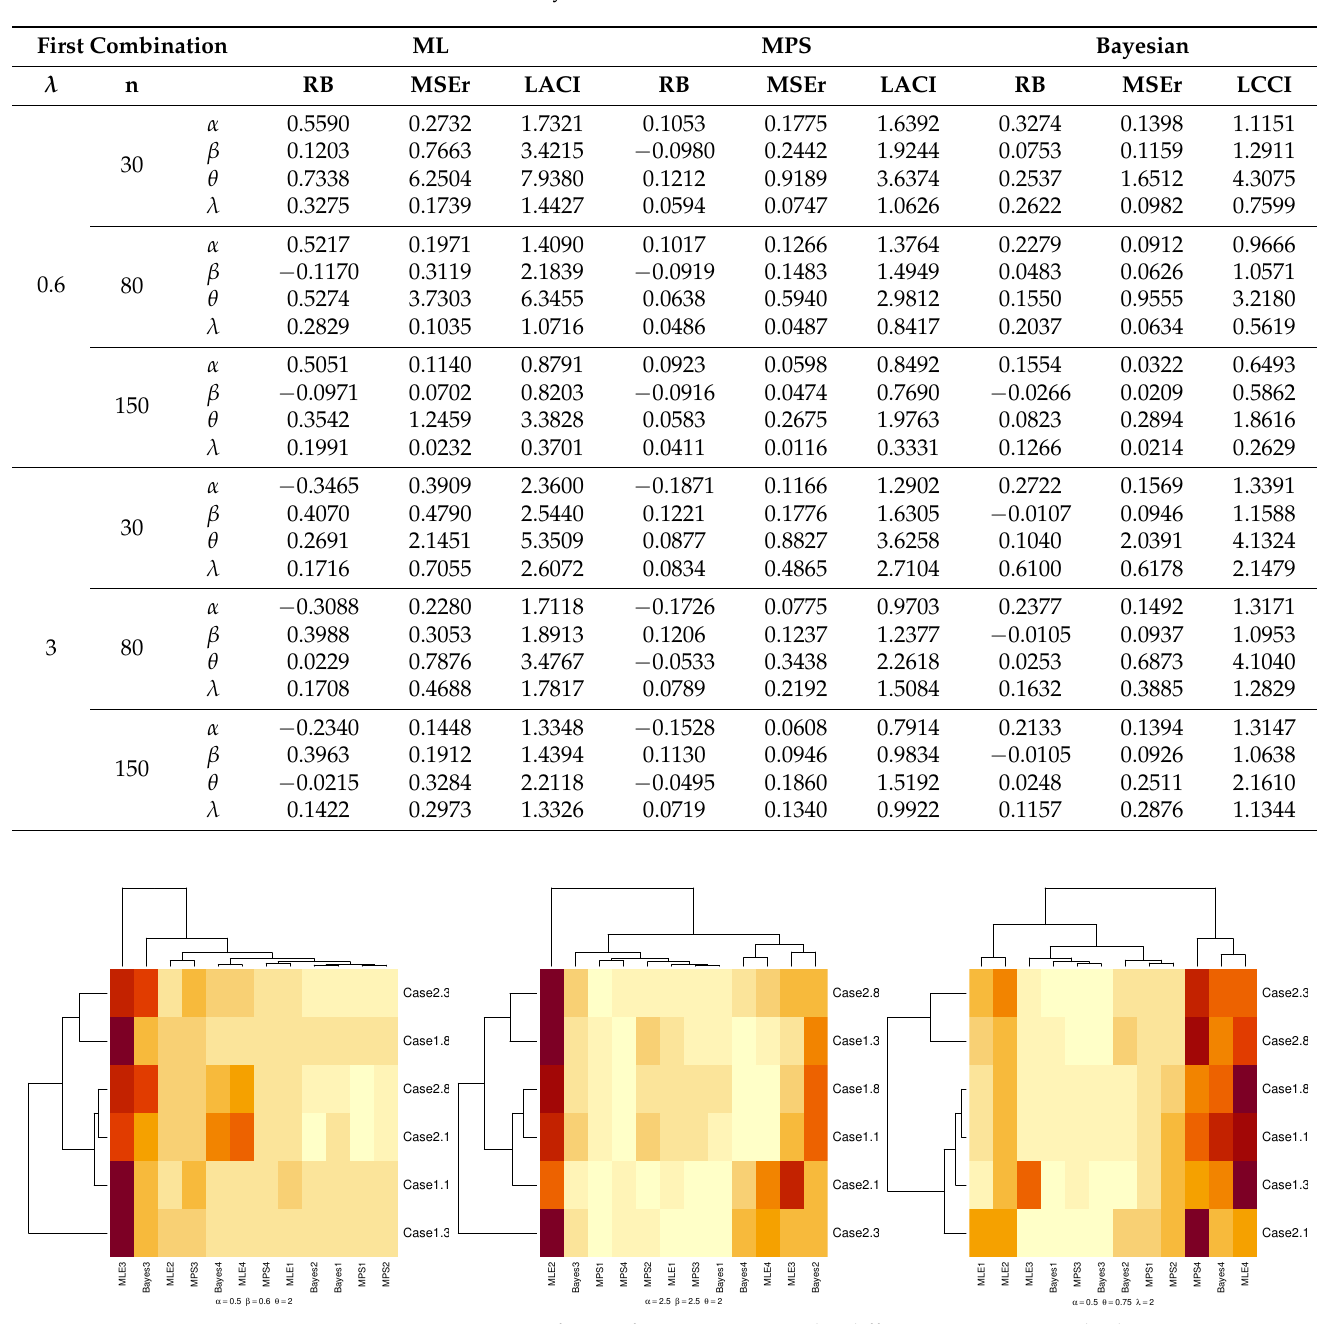
Figure 4. Heatmaps of MSEr for parameters under different estimation